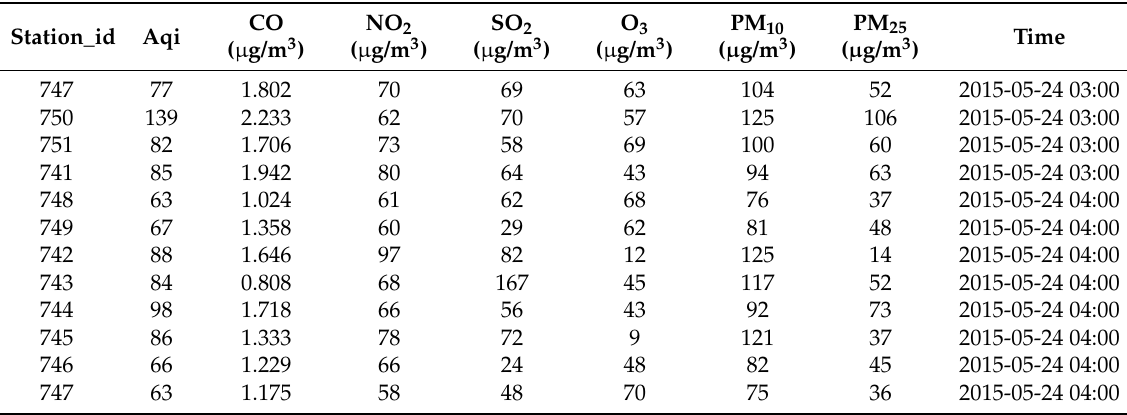
Table 3. Data samples of monitoring